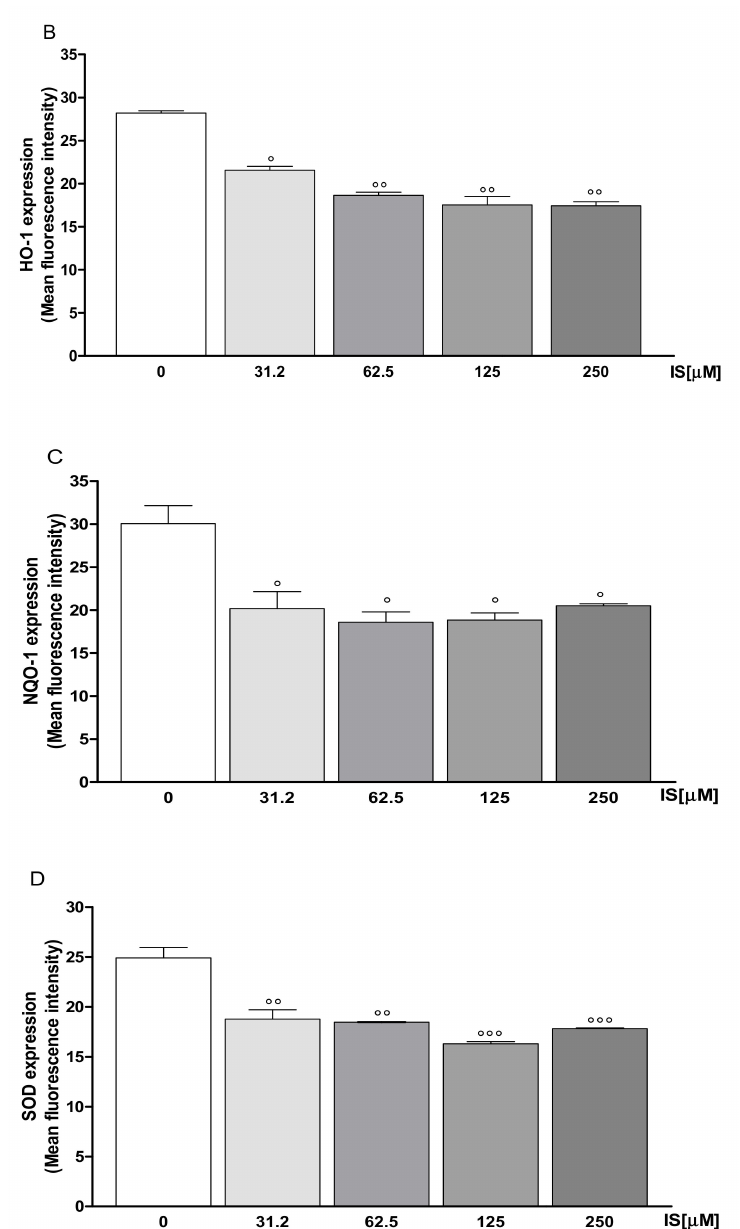
Figure 2. E ff ect of IS (125, 250 µ M) on Nrf2 (Panel A ) nuclear translocation in IEC-6 cells. Nrf2 translocation was observed using immunofluorescence confocal microscopy ( n = 15). Scale bar, 10 µ m. Blue fluorescence indicated the localization of nuclei (DAPI) and green indicated the localization of Nrf2. E ff ect of IS (31.2–250 µ M) on HO-1 (Panel B ), NQO1 (Panel C ), SOD (Panel D ) expression in IEC-6 cells. Values are expressed as mean fluorescence ± s.e.m. ( n = 15). ◦◦◦ , ◦◦ and ◦ denote respectively p < 0.001, p < 0.01 and p < 0.05 vs.